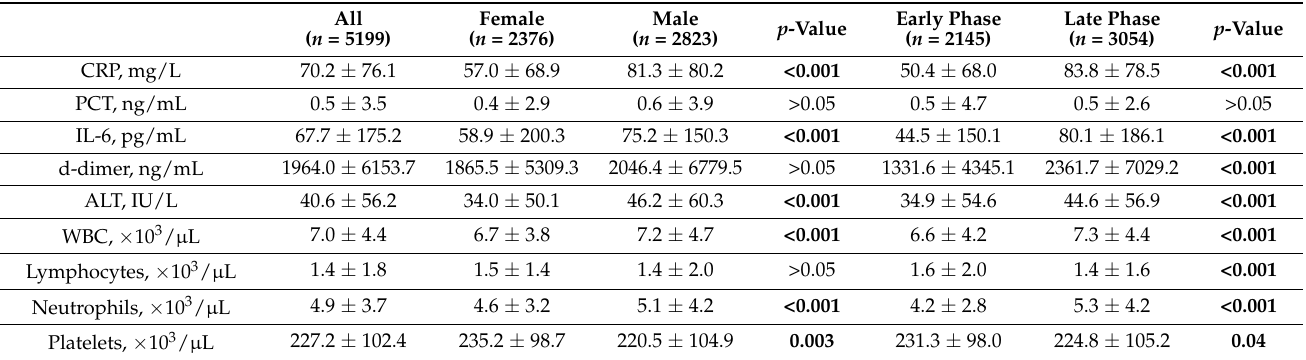
Table 3. Laboratory parameters (mean ± SD) of hospitalized patients and differences between women and men, and early and late phase of the COVID-19 pandemic evaluated with Student’s t -test.